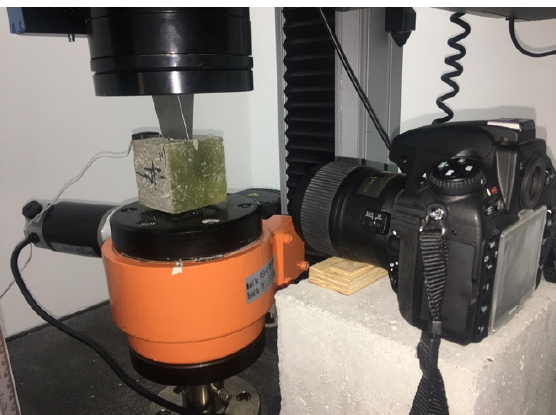
Figure 9. Test stand for testing tensile cracking characteristics when splitting concrete sample with a wedge (WSP) using digital image correlation (DIC) method.